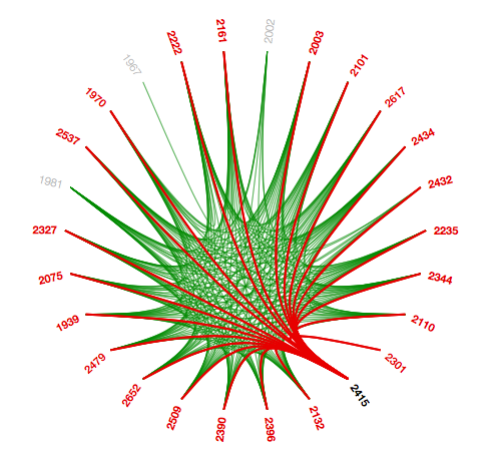
Figure 13. Represents a selection interaction in Hierarchical Edge Bundling.